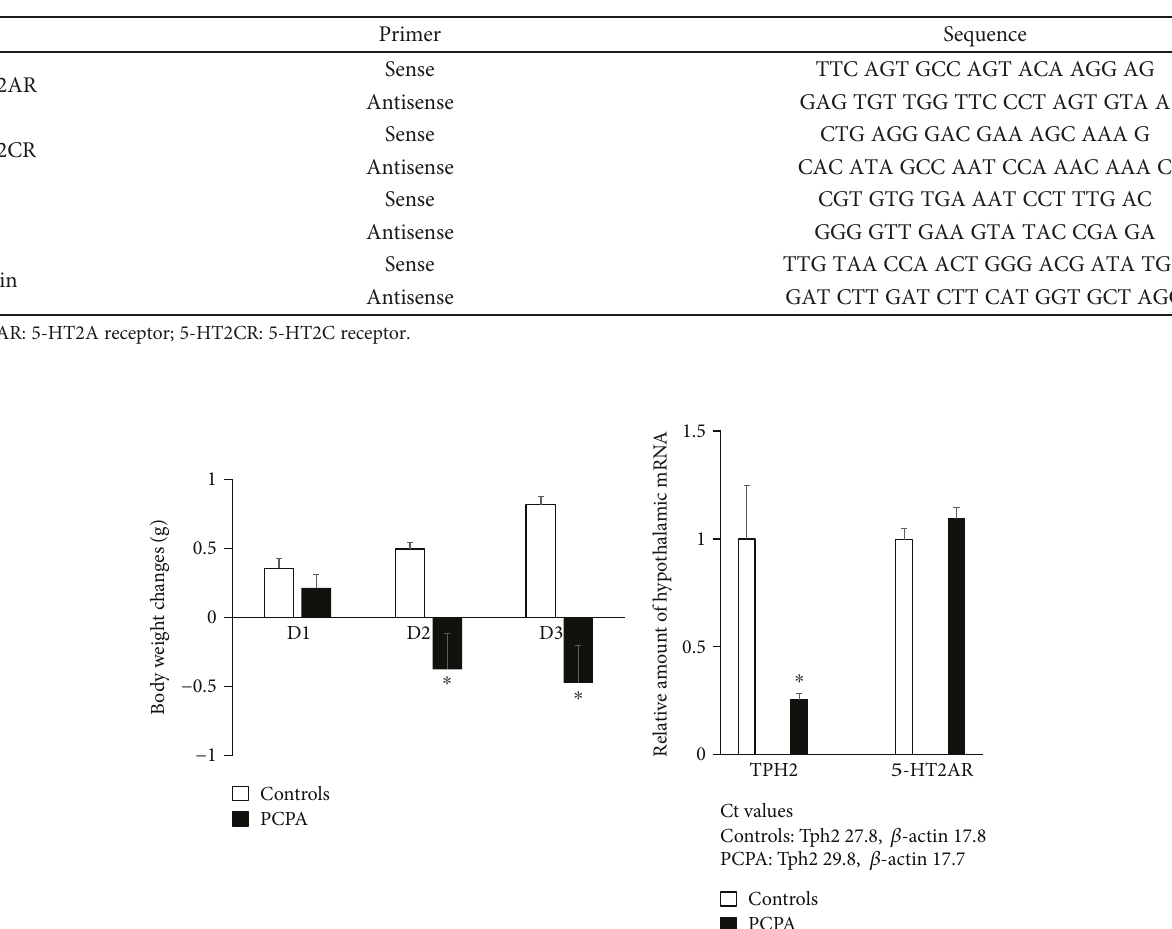
Table 1: Primers used for real-time RT-PCR.